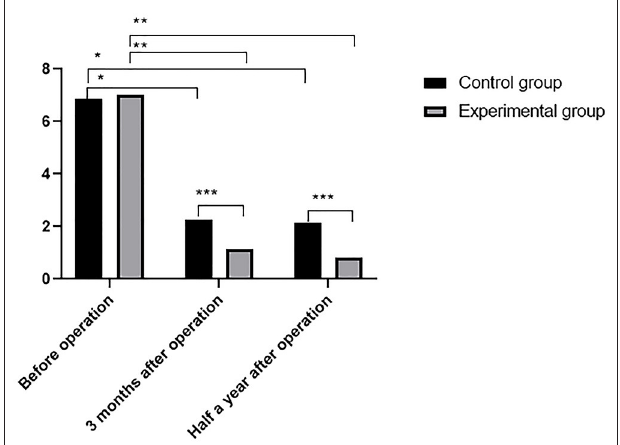
FIGURE 1 | Comparison of VAS scores ( x ± s). The abscissa indicates the time point of pain evaluation before operation, 3 months postoperatively and 6 months postoperatively, and the ordinate indicates the score. VAS scores of control group before operation, 3 months postoperatively and 6 months postoperatively were (6.85 ± 1.21), (2.25 ± 1.64), and (2.14 ± 1.27), respectively. VAS scores of experimental group before operation, 3 months